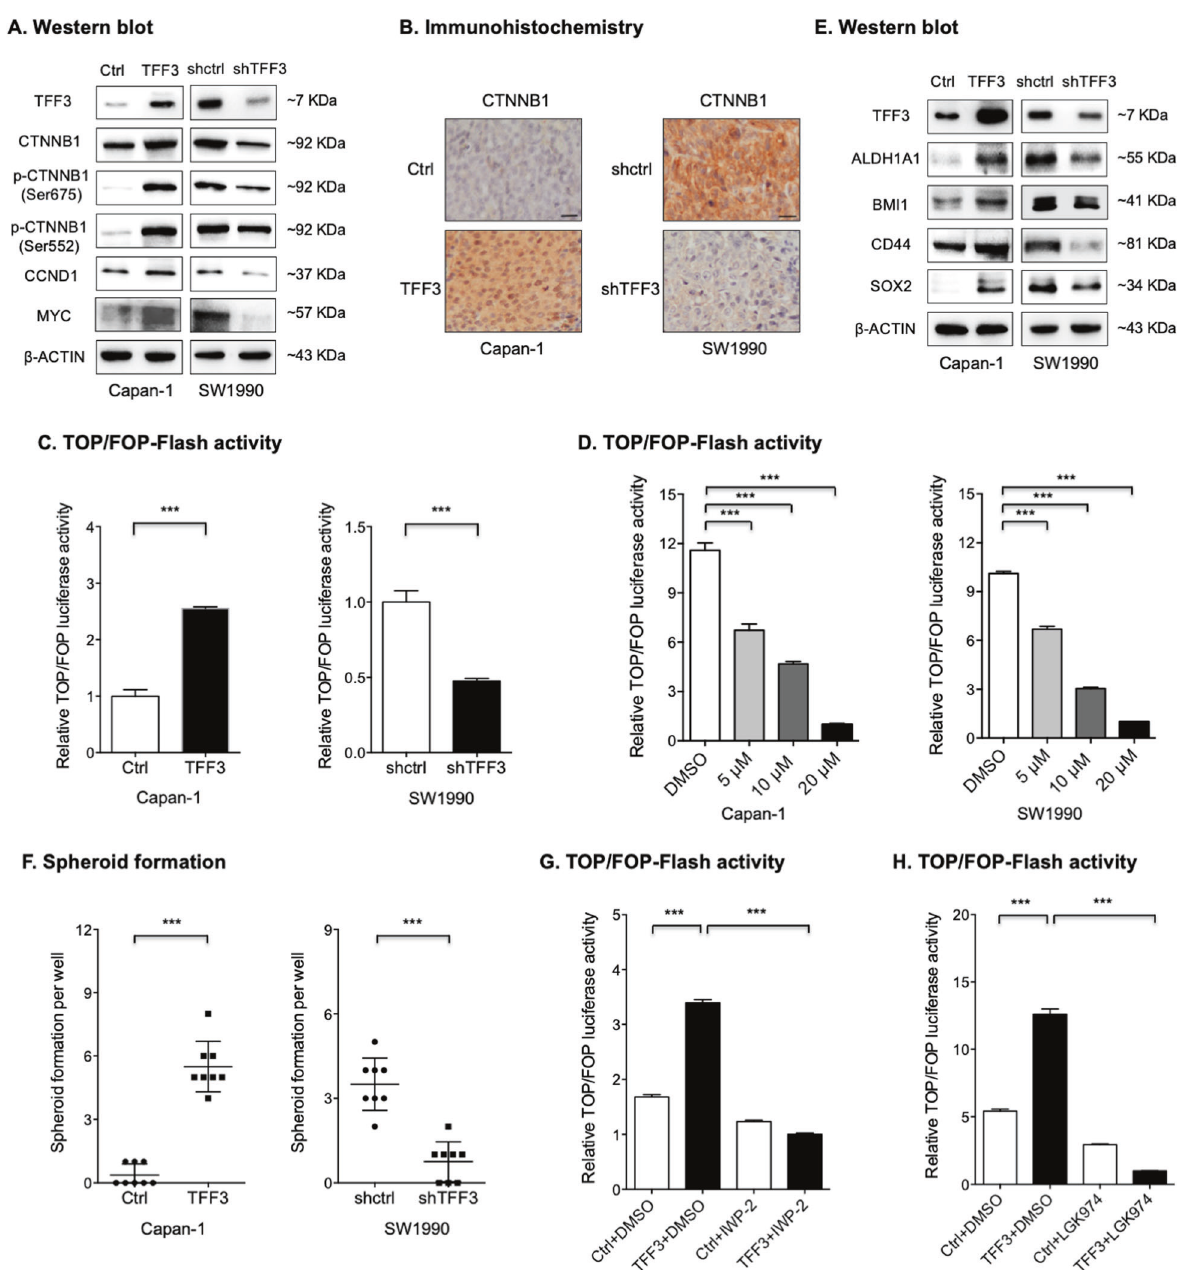
Fig. 6 TFF3 activated WNT signaling by inducing WNT ligand expression in PDAC. A Western blot analysis was performed to determine the expression of WNT-related proteins in Capan-1-TFF3, SW1990-shTFF3, and the corresponding control cells. β -actin was used as input control. B Representative micrographs of IHC staining for CTNNB1 in the indicated xenografts. Scale bar, 20 μ m. C Relative TOP/FOP luciferase activity analysis was performed to determine the change of CTNNB1/TCF transcription activity in Capan-1-TFF3, SW1990-shTFF3, and the respective control cells. D Relative TOP/FOP luciferase activity analysis was performed to determine the change of CTNNB1/TCF transcription activity in Capan-1 and SW1990 cells after AMPC treatment. E Western blot analysis was performed to determine the protein expression of stemness- associated genes in Capan-1-TFF3, SW1990-shTFF3, and the corresponding control cells. β -actin was used as input control. F Spheroid formation assay for Capan-1-TFF3, SW1990-shTFF3, and the respective control cells. G , H TOP/FOP luciferase activity analysis was performed to determine the change of CTNNB1/TCF transcription activity in Capan-1-TFF3 and the control cells after the suppression of WNT ligand secretion with 10 μ M IWP-2 ( G ) or LGK-974 ( H ) treatment for 48 hours.